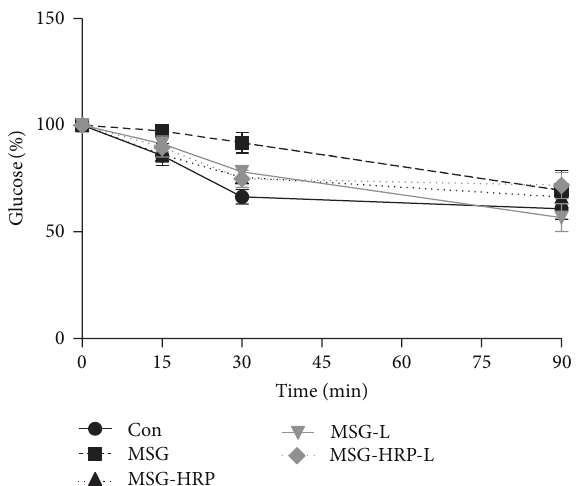
Figure 2: Insulin tolerance test was performed in all of the animals. The decreased rate of blood glucose was smaller in the MSG group compared with the Con group at 30min after insulin injection. Treatment with HRP, losartan, and both HRP and losartan had higher decreased rate of blood glucose when compared with the MSG